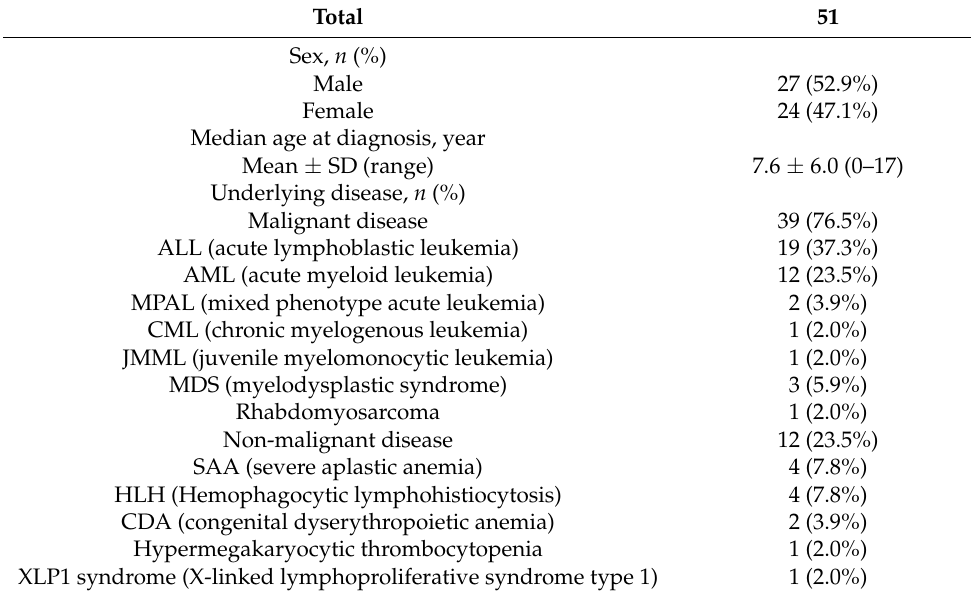
Table 2. Baseline characteristics of the study cohort and received